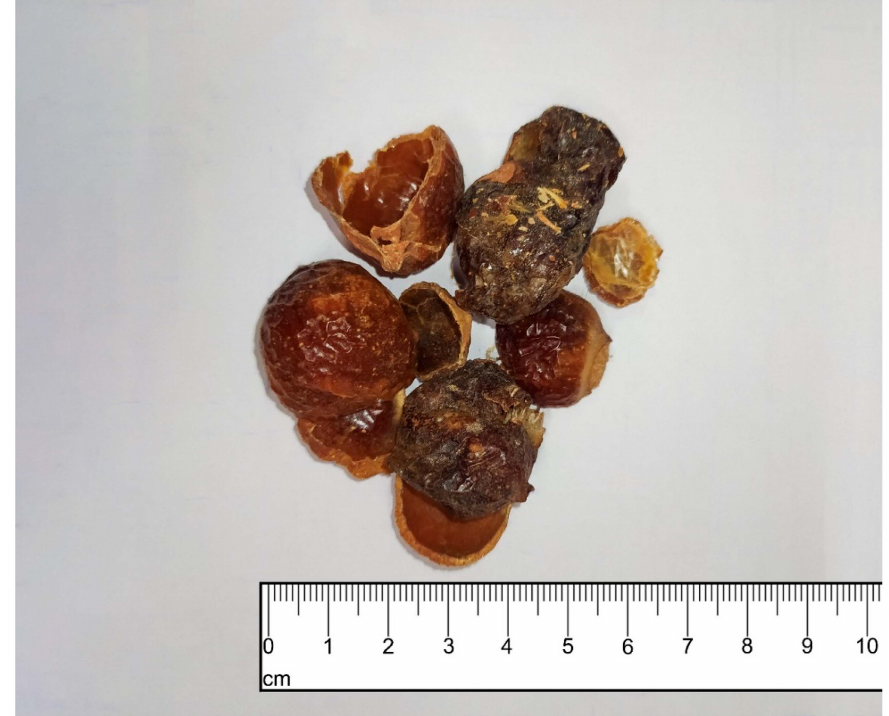
Figure 2. Commercially available, dry washnut pericarps.